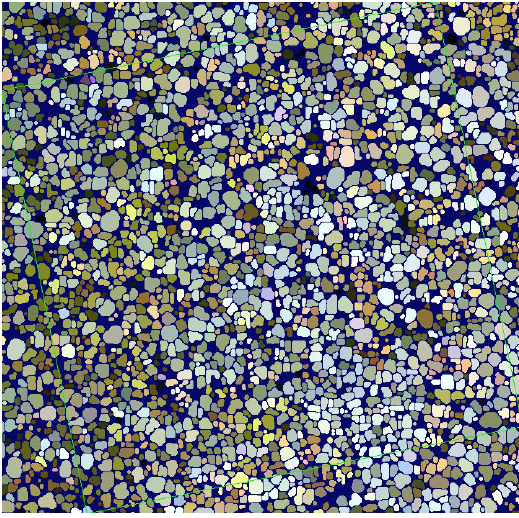
Figure 6. Results of individual tree spectrum extraction and merging (R: 693.6 nm; G: 533.6 nm; B: 459.7 nm).